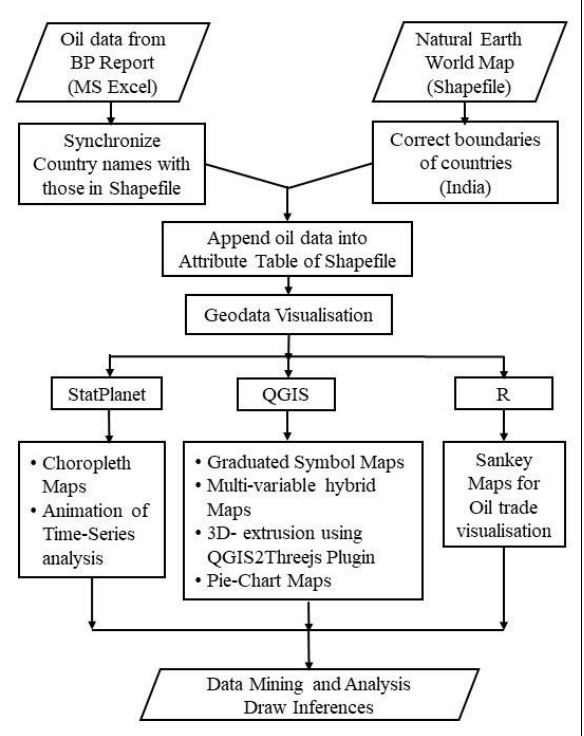
Figure 1. Methodology flowchart for geodata visualisations.